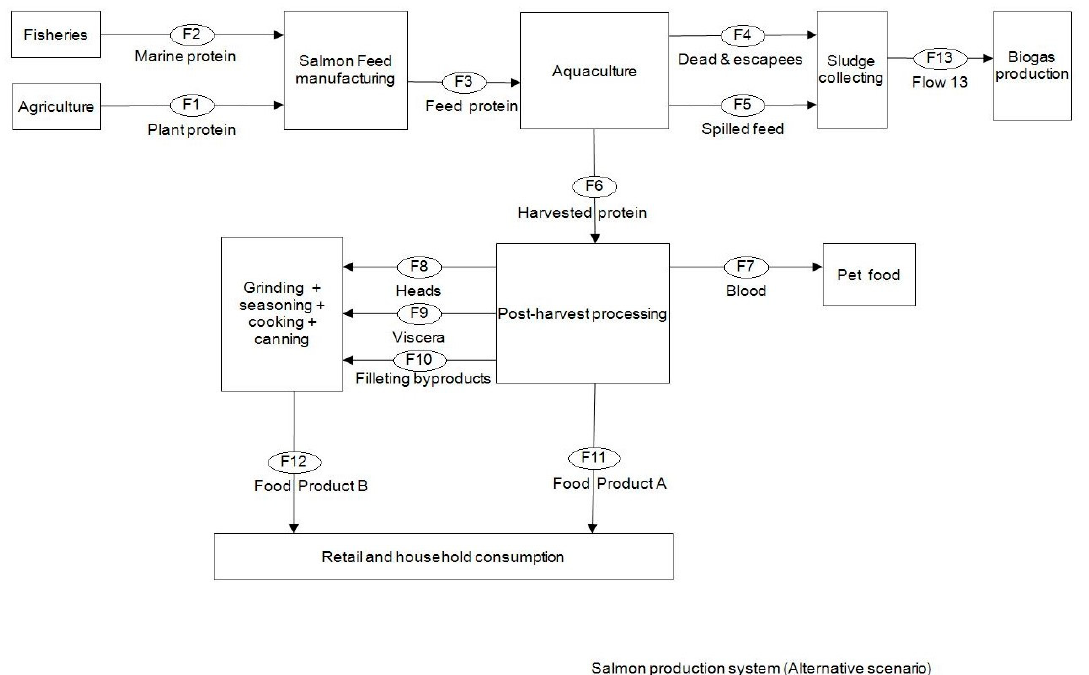
Figure 5. Alternative scenario.